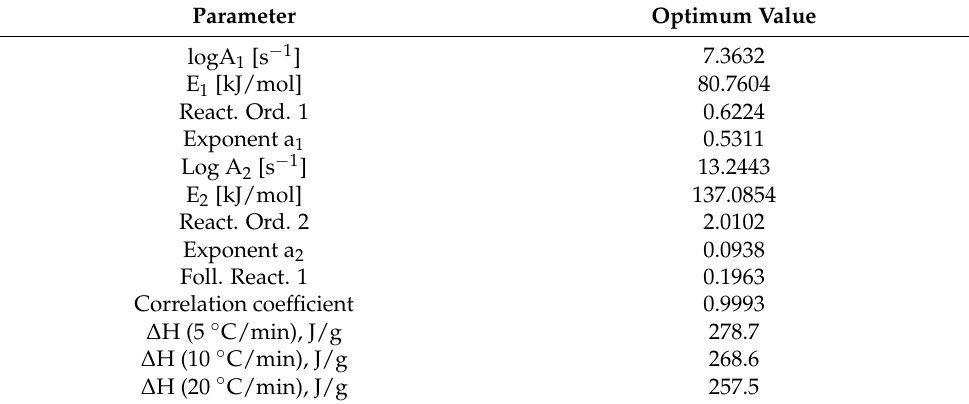
Table 5. Parameters for resulting two-step model for formulation 2.